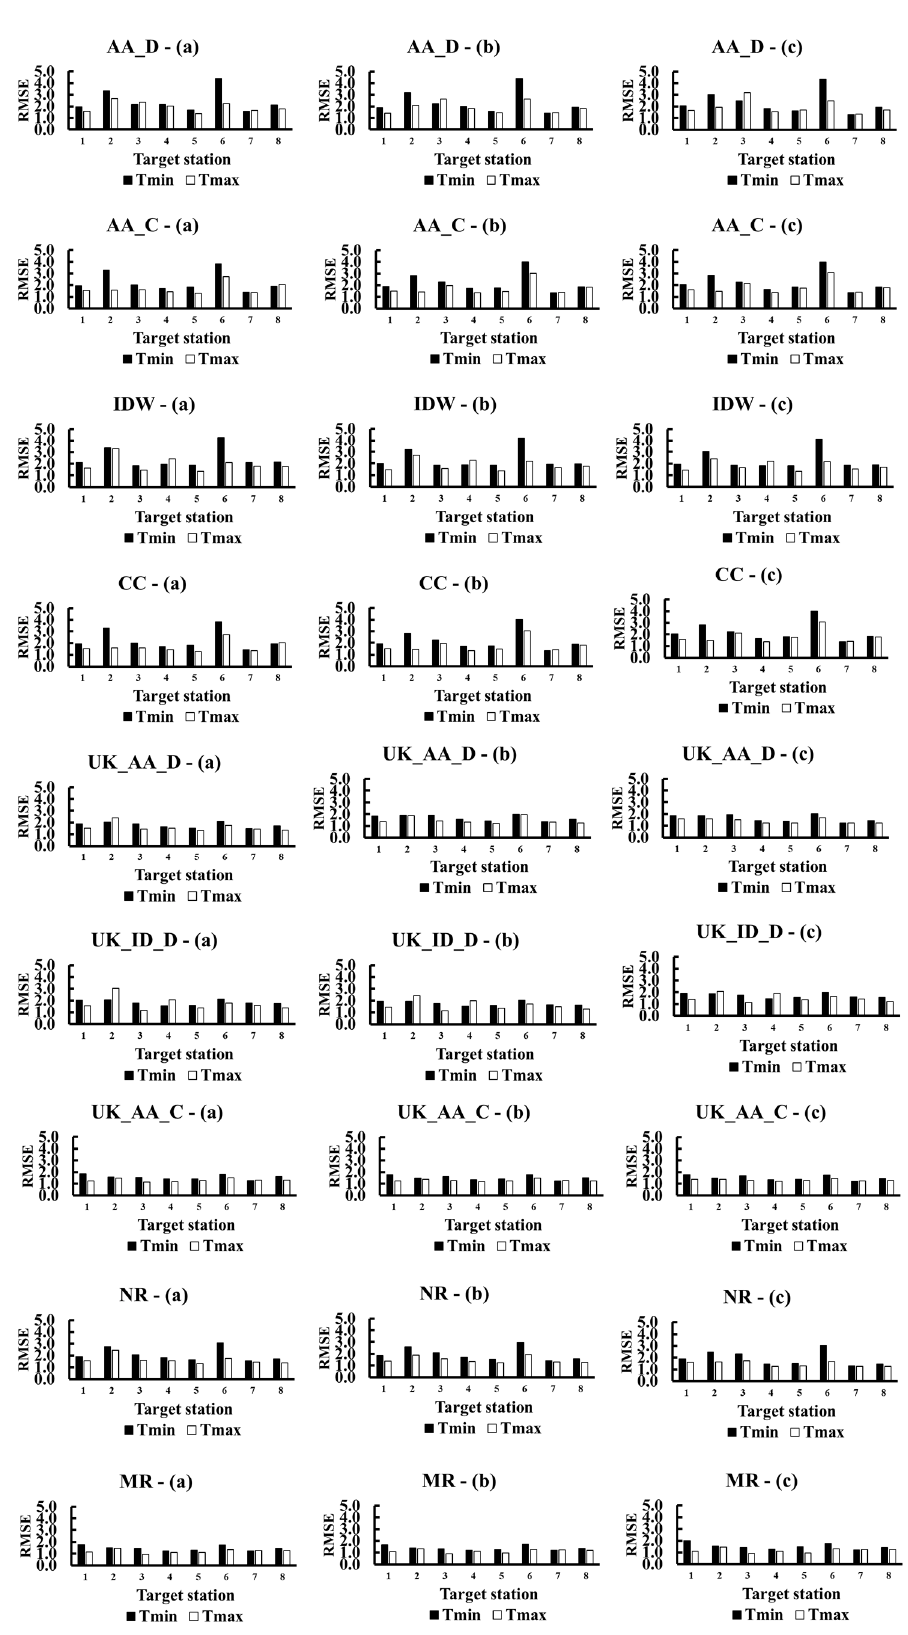
Figure 4. Root mean square error (RMSE) for estimating minimum and maximum temperatures for each infilling method at all target stations using ( a ) three target stations, ( b ) 5 target stations and ( c ) 8 target stations.